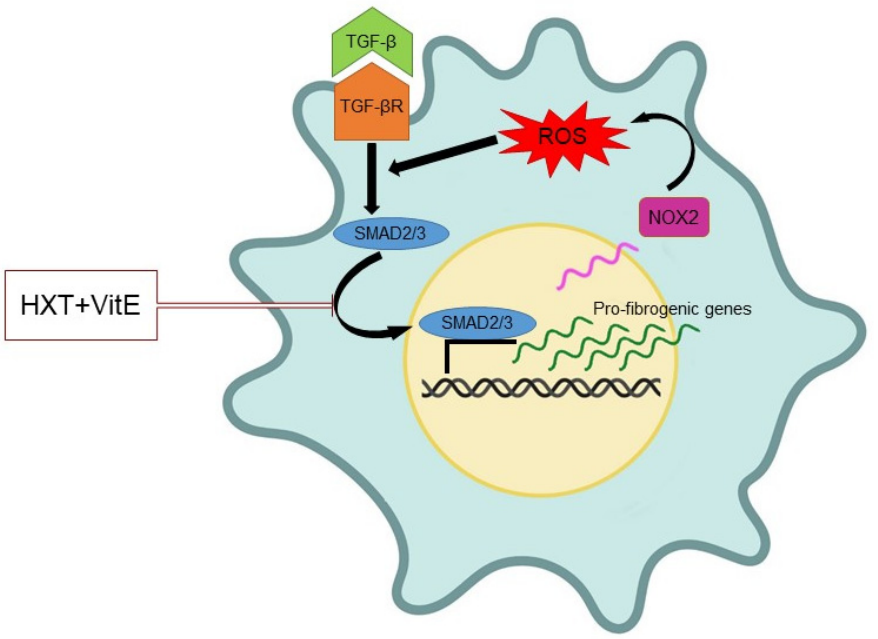
Figure 7. Schematic representation of the mechanism of action of HXT + VitE treatment in TGF- β - activated HSCs. Partially created with BioRender.com.